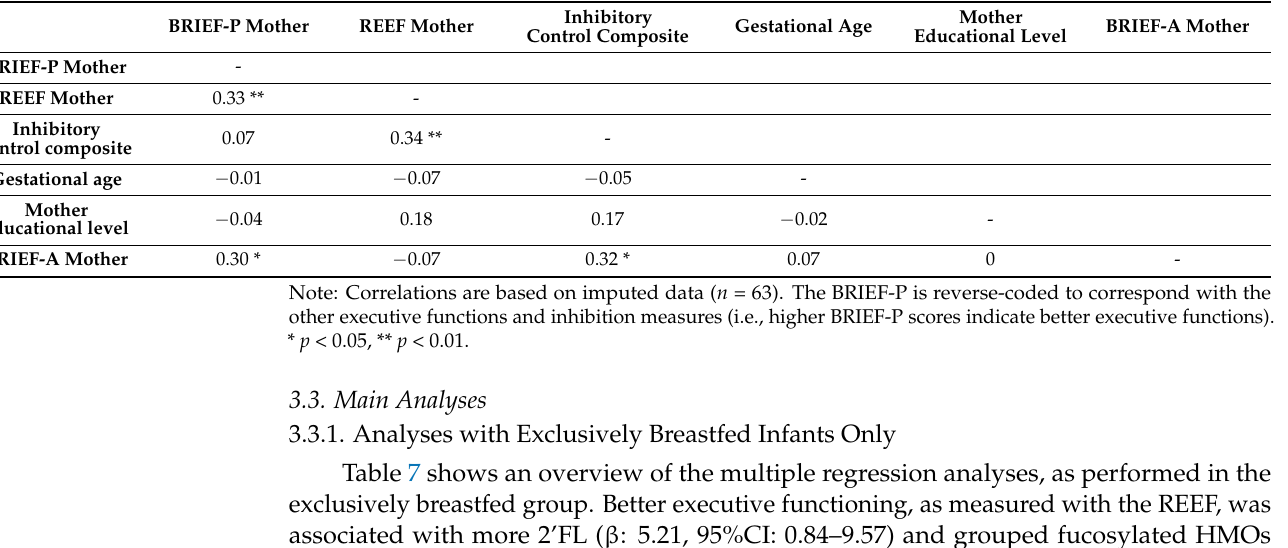
Table 6. Correlations between executive function measures and potential confounding